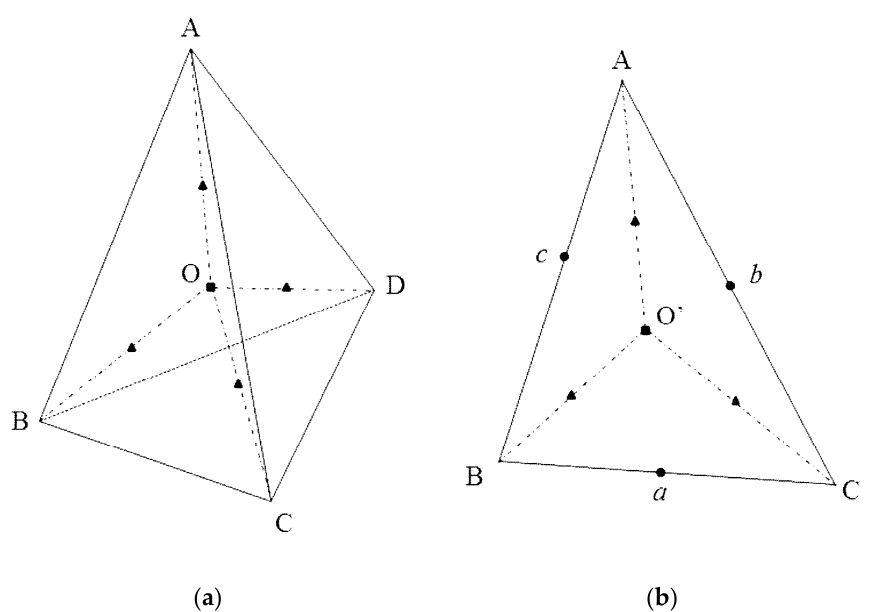
Figure 4. Characteristic points for a tetrahedrom. ( a ) Interior points; ( b ) Boundary points.